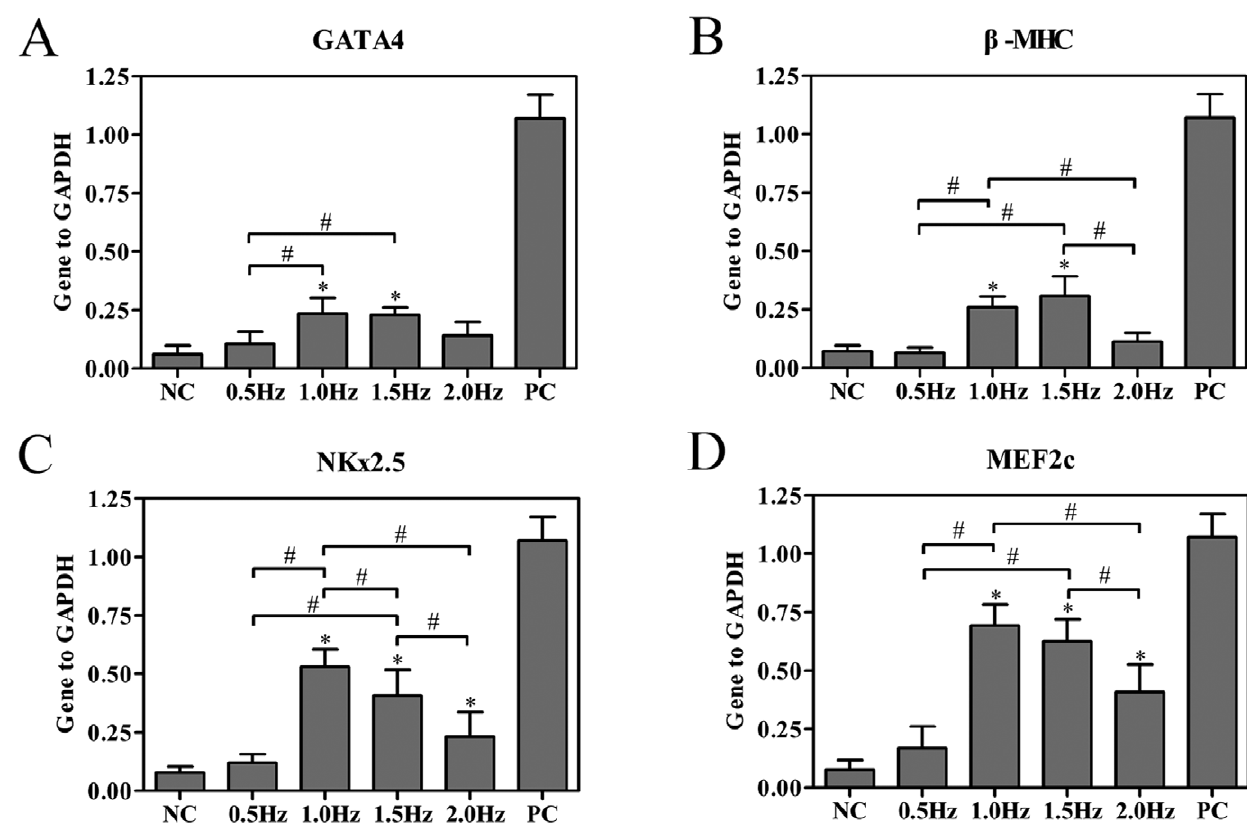
Figure 4. Effects of the stretch frequency on the cardiac-related gene expressions of rBMSCs. rBMSCs were cultured under static conditions or exposed to cyclic strain of 10% elongation at 0.5, 1, 1.5 and 2 Hz for 24 h and mRNA expression levels of GATA-4, b -MHC, NKx2.5 and MEF2c were assessed on the 7 th day by quantitative real-time RT-PCR analysis. The expression of each gene was normalized based on the expression of GAPDH. (A) GATA4. (B) b -MHC. (C) NKx2.5. (D) MEF2c. NC, negative control (rBMSCs treated with regular complete medium); PC, positive control (normal neonatal rat cardiomyocytes). Results are shown as the mean 6 SD values (n=4). * P , 0.05 compared to the NC group; # P , 0.05.